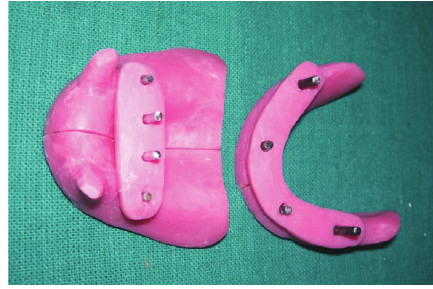
Figure 2: Sectional special tray.